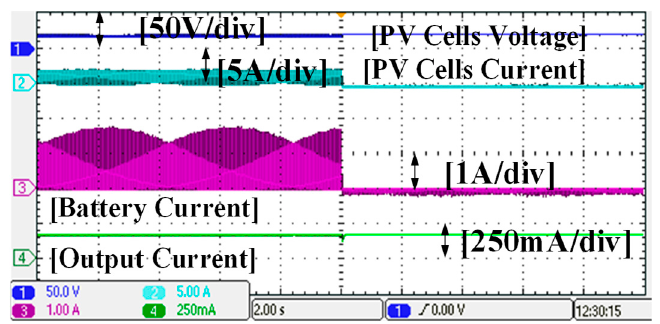
Figure 16. SIDO mode switches to DISO mode.